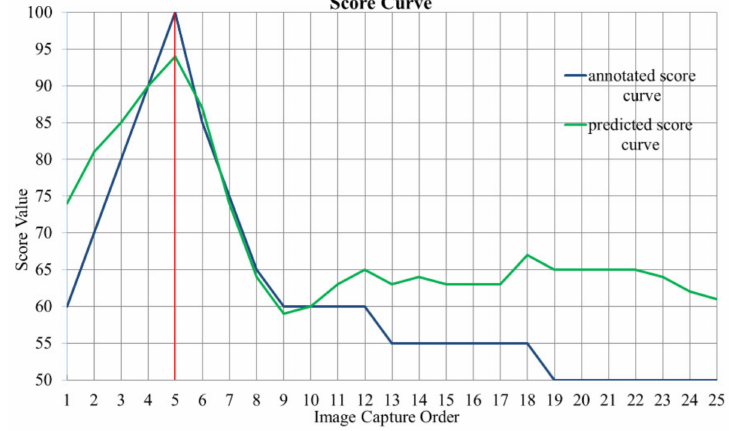
Figure 7. Score curve of one fecal microscopic image group in test set. The abscissa is the image capture order in the autofocus process, and the 5th image is the clearest image. The ordinate is the score value. The blue and green curve represent annotated and predicted score curve, respectively.